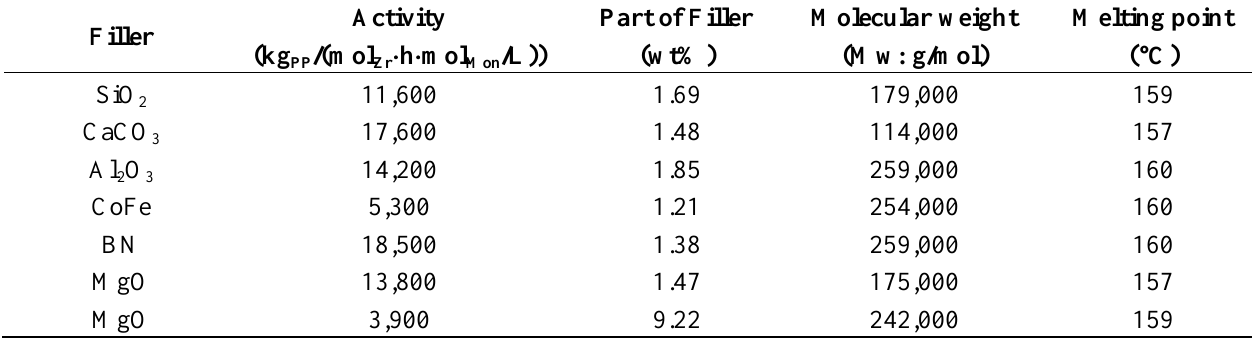
Table 2. Polypropylene nanocomposites of different inorganic nanoparticles and different parts of filler by in-situ polymerization with metallocene